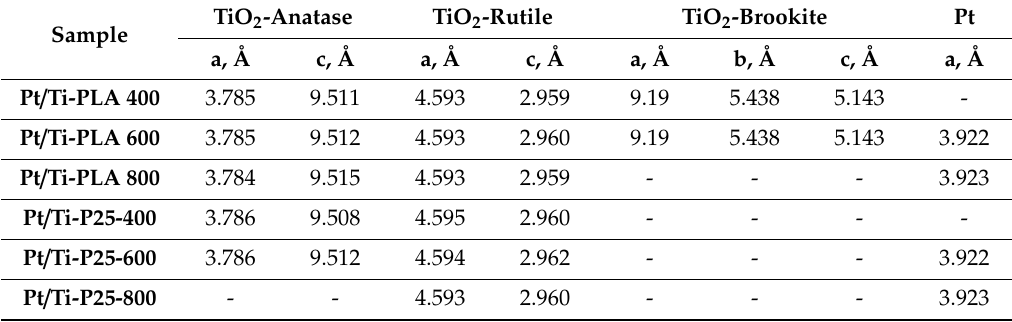
Table A2. Results of EXAFS fitting to a structural model containing O and Pt nearest neighbors.